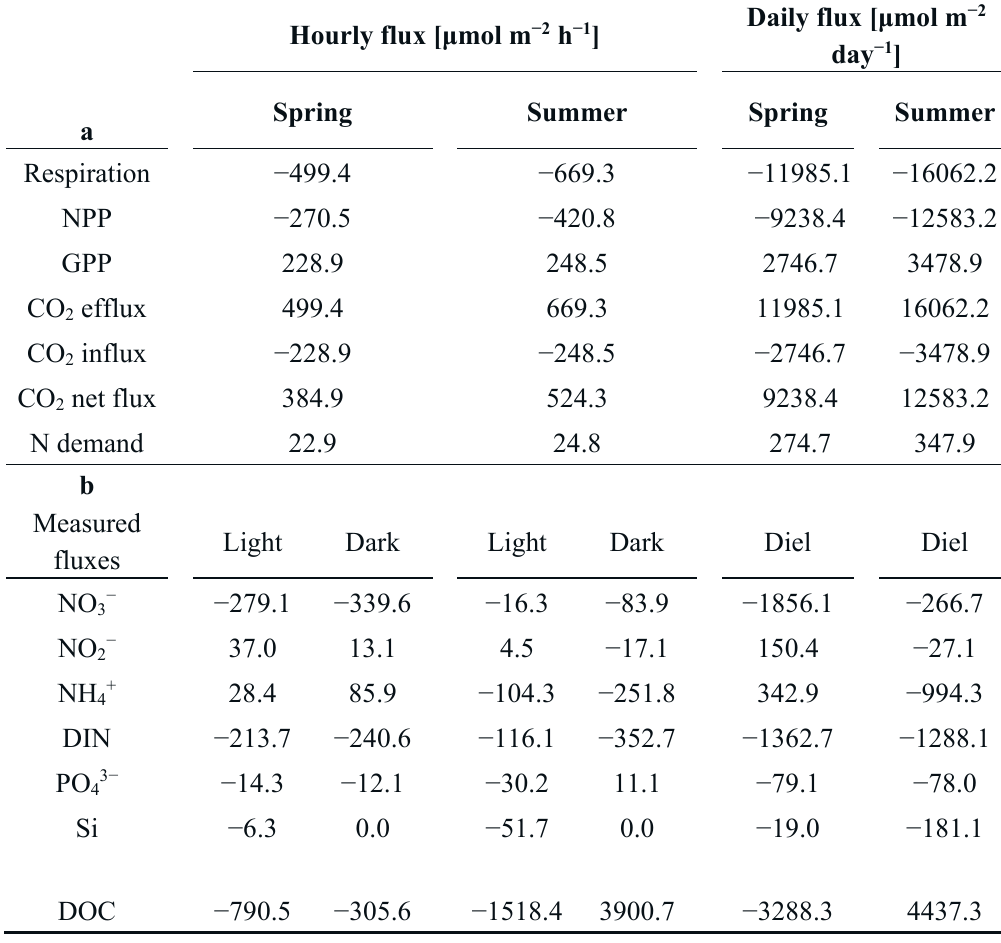
Table 2. Hourly and diel benthic fluxes. ( a ) Respiration, NPP, and GPP (all in μ mol O 2 ), as well as calculated CO 2 flux and nitrogen (N) demand, assuming a respiratory quotient (RQ) of 1 and a C:N ratio for microphytobenthos of 10, diel fluxes are based on 12 and 14 hours of daylight in March and October, respectively; ( b ) Nutrient fluxes measured during core incubations. Diel fluxes are based on an inundation time of 6 h per